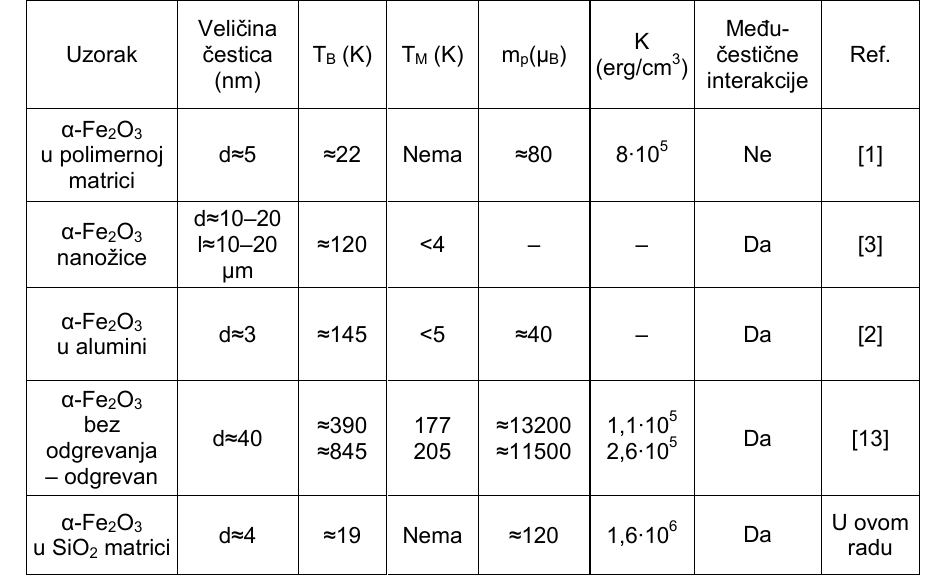
Comparative review of magnetic parameters of several distinct nanosized α -Fe 2 O 3 systems Veli č Uzorak